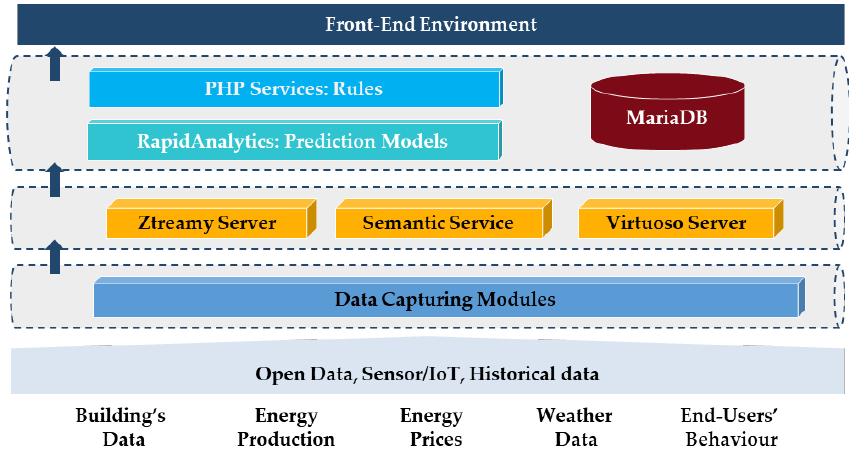
Figure 1. Internal architecture.